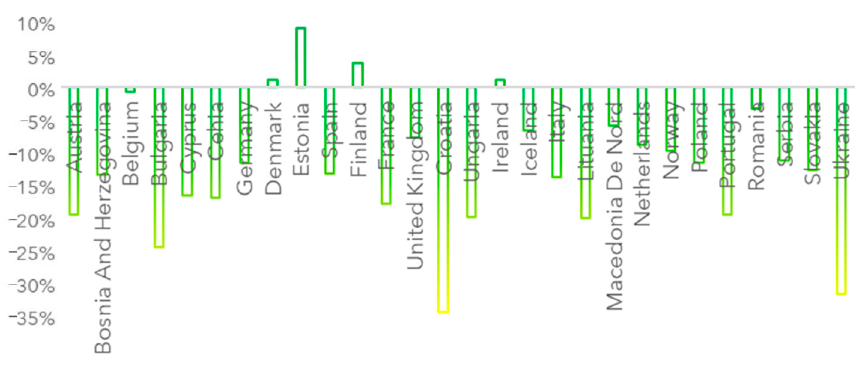
Figure 3. Air pollution changes (API change ) from March to October 2020.